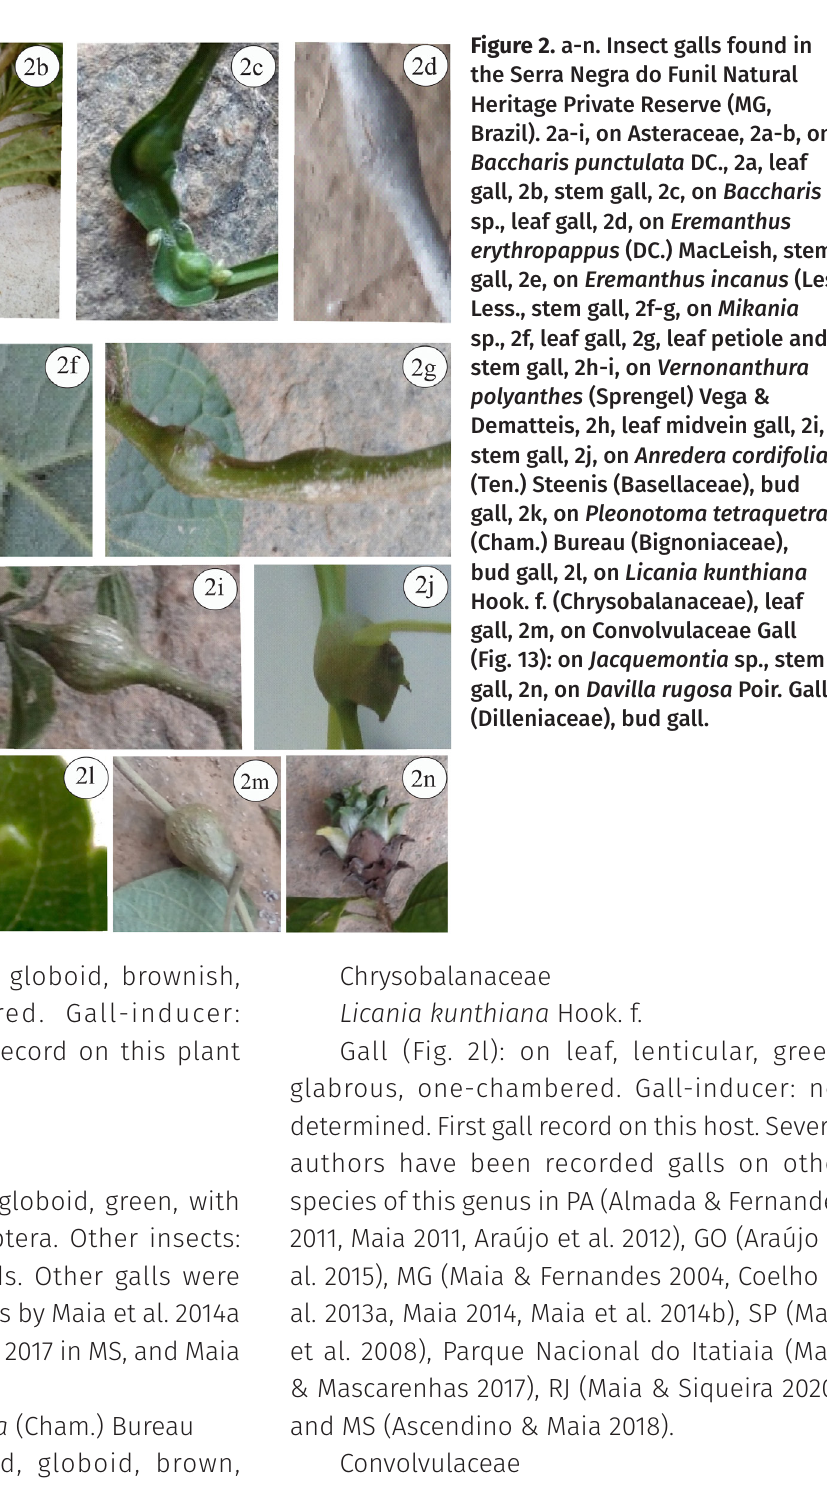
one-chambered. Gall-inducer: Cecidomyiidae.